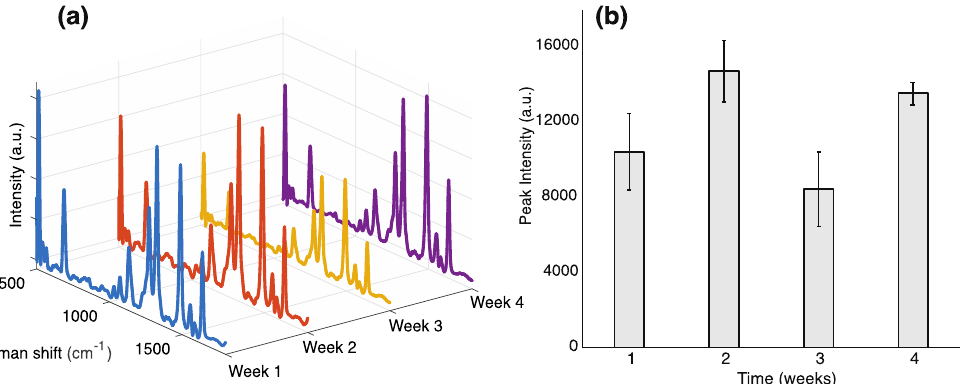
Figure 2. Longevity analysis of the dendritic SERS substrates. Four spectra of R6G were taken every week from simultaneously prepared substrates, for a period of 4 weeks. Week 1 corresponds to time zero (time of dendrite preparation) + 1 week. ( a ) The R6G spectrum was distinctly identifiable every week for 4 weeks. These spectra were taken at a concentration 10 −5 M, with 10 s acquisition time. ( b ) The average intensity of the key peak at 1360 cm −1 was plotted over 4 weeks. The error bars represent the standard deviation of the data.